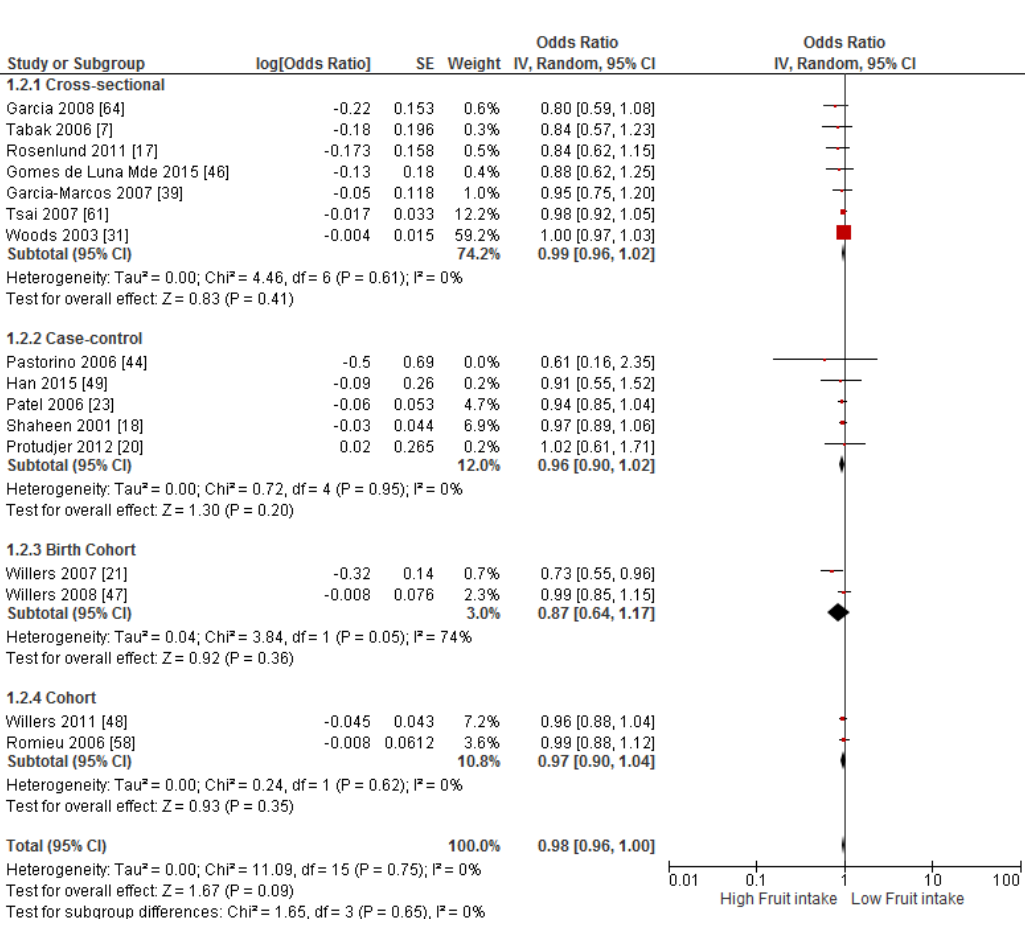
Figure 3. Meta ‐ analysis of the association between fruit intake and risk of prevalent asthma. Figure 3. Meta-analysis of the association between fruit intake and risk of prevalent asthma. Nutrients 2017 , 9 , 341